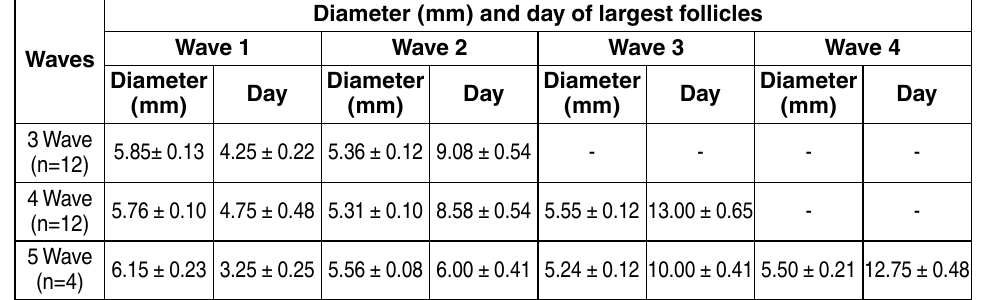
table 4 . The day of ovulation in first and second oestrous cycles of Malabari doelings Oestrous cycle